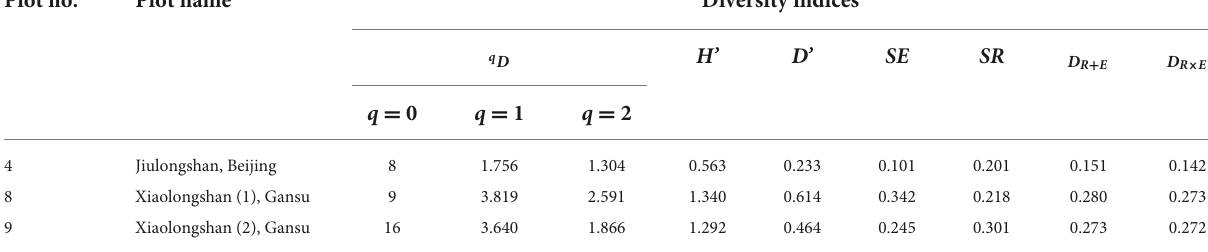
TABLE 5 Tree species diversity of different artificial mixed forests locating in different climate zones. Plot